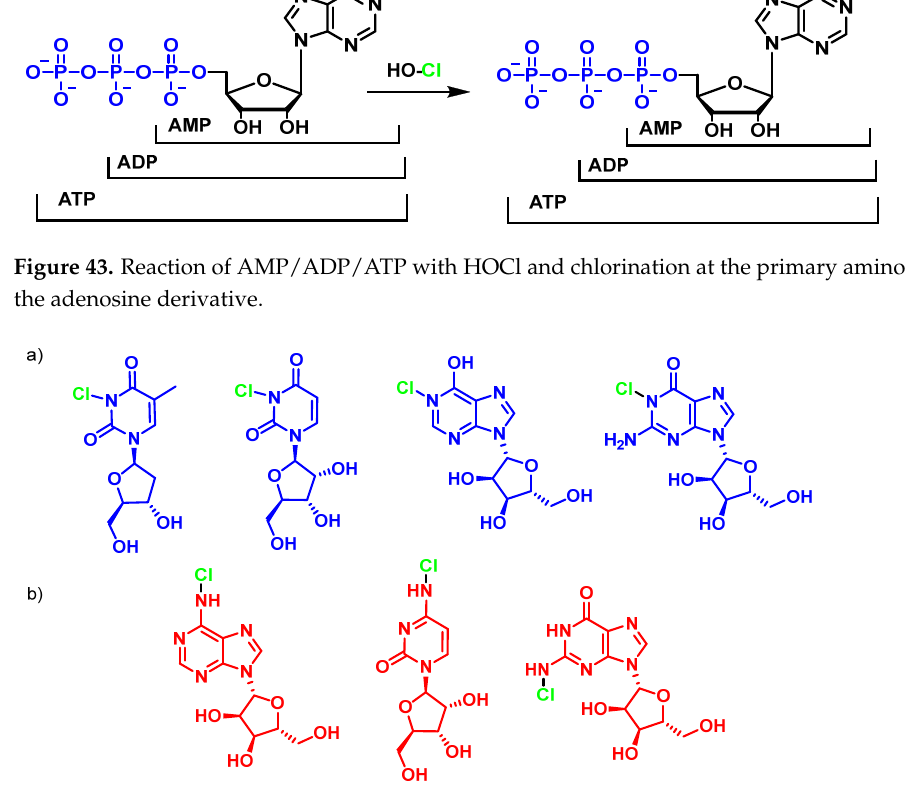
Figure 44. ( a ) Faster NH-chlorination of thymidine, uridine, inosine, and guanosine; and ( b ) slower –NH 2 chlorination of adenosine, cytidine, and guanosine.